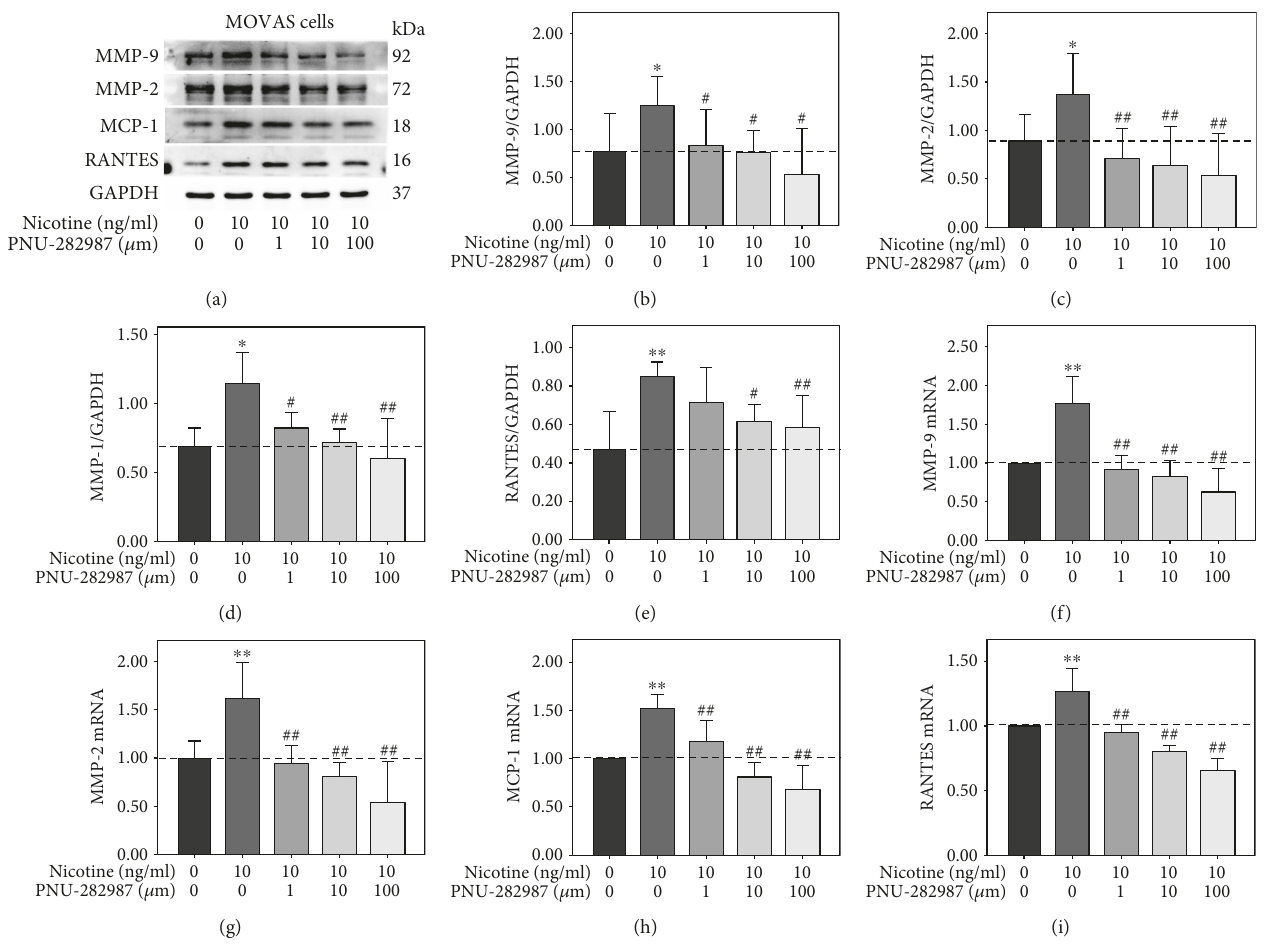
Figure 7: PNU-282987 downregulated nicotine-induced expression of matrix metalloproteinase- (MMP-) 9, MMP-2, monocyte chemotactic protein- (MCP-) 1, and regulated upon activation normal T cell expressed and secreted (RANTES) in MOVAS cells. (a) MOVAS cells were pretreated with 10 μ m PNU-282987 for 60 min prior to 10ng/ml nicotine exposure for 3 h. The band optical density values (means ± SD) of (b) MMP-9, (c) MMP-2, (d) MCP-1, and (e) RANTES in the Western blot were quanti fi ed by using ImageJ software and normalized to GAPDH. Representative results from three independent experiments are shown. (f) MMP-9, (g) MMP-2, (h) MCP-1, and (i) RANTES mRNA levels were determined by real-time reverse transcription polymerase chain reaction. All experiments were analyzed as triplicate independent experiments. ∗ p < 0 05 and ∗∗ p < 0 01 versus controls; # p < 0 05 and ## p < 0 01 versus the group treated with